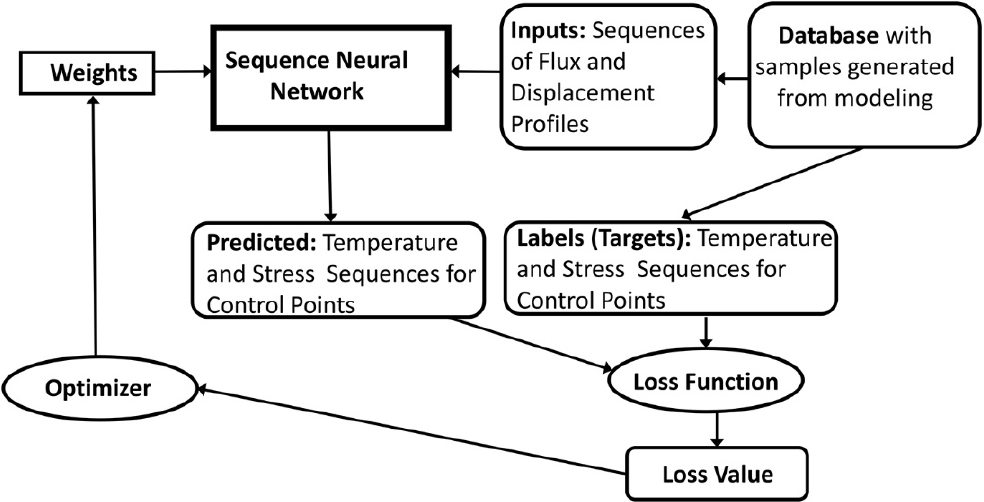
Figure 8. Training process in sequence deep learning.